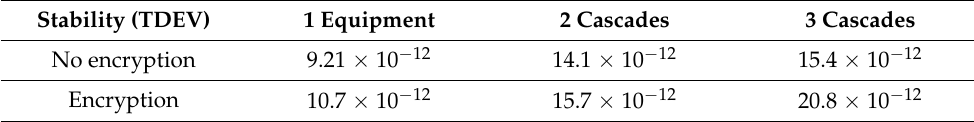
Table 3. Comparison of TDEV at 1 s averaging time with cascade